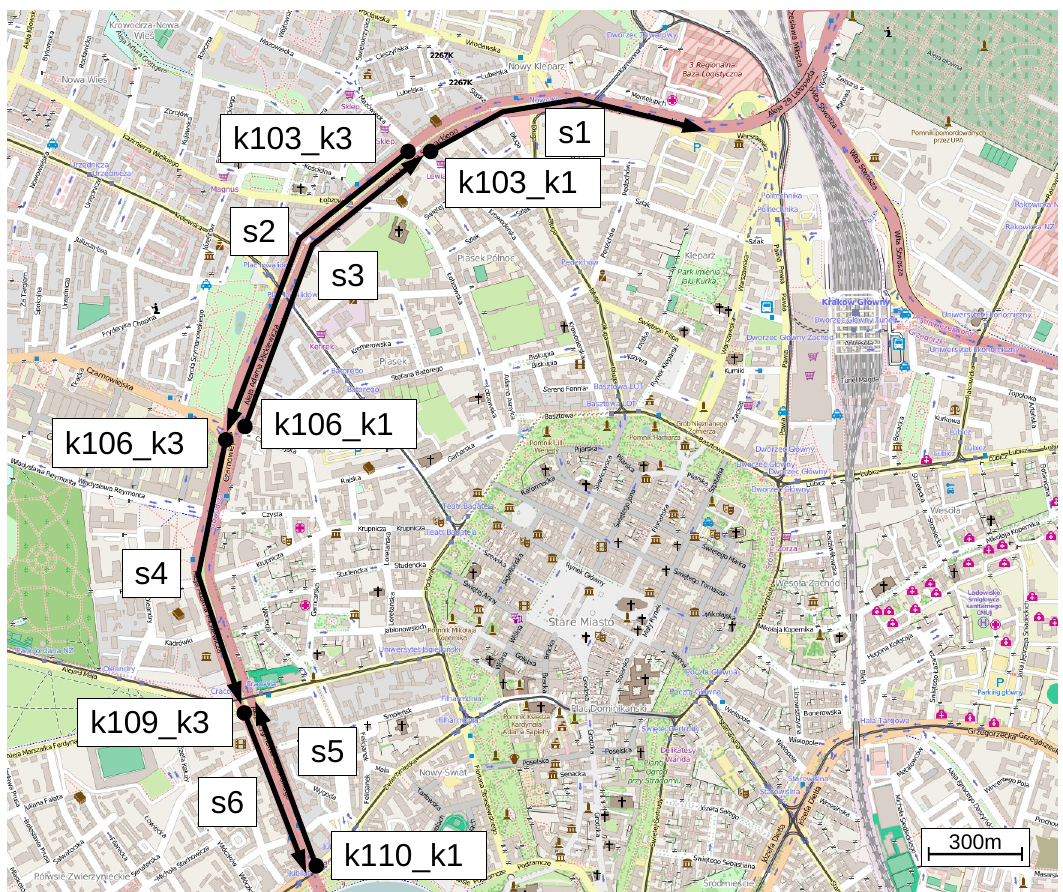
Figure 2. Map presenting the case under